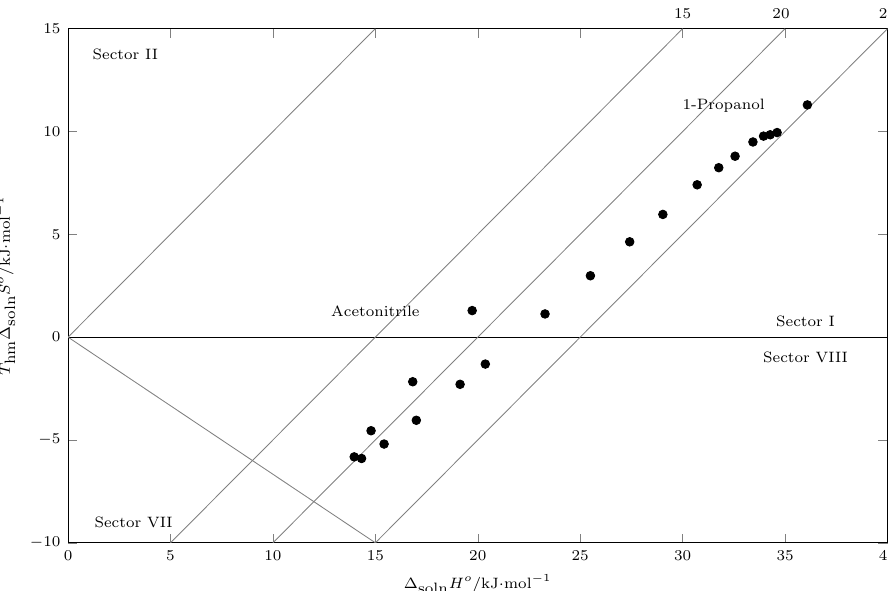
Figure 3. Relation between enthalpy ( ∆ soln H ◦ ) and entropy ( T hm ∆ soln S ◦ ) in terms of the process of sulfadiazine (3) solution in {MeCN (1) + 1-PrOH (2)} cosolvent mixtures at 297.6 K. The isoenergetic curves for ∆ soln G ◦ are represented by dotted